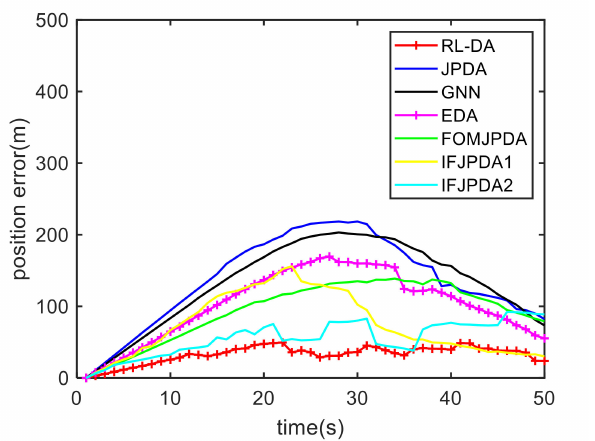
Figure 21. Comparison of the position errors for Target 1 in Case